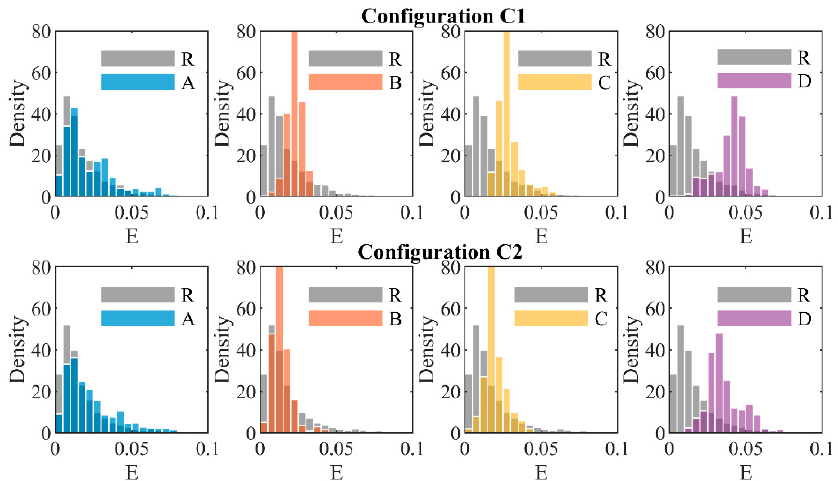
Figure 10. S101 bridge: Histogram plots of the instantaneous values of the interpolation error 𝐸 at sensor 10 for different damage states and sensor subset configurations.